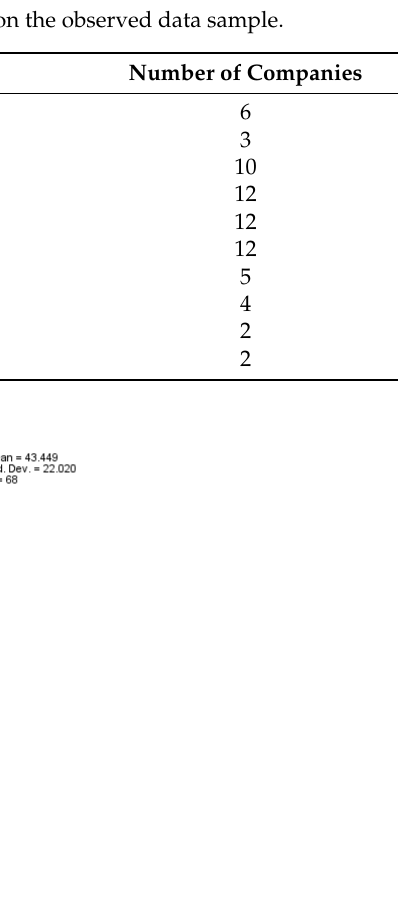
Figure 1. Histogram of the CIOICTI distribution.